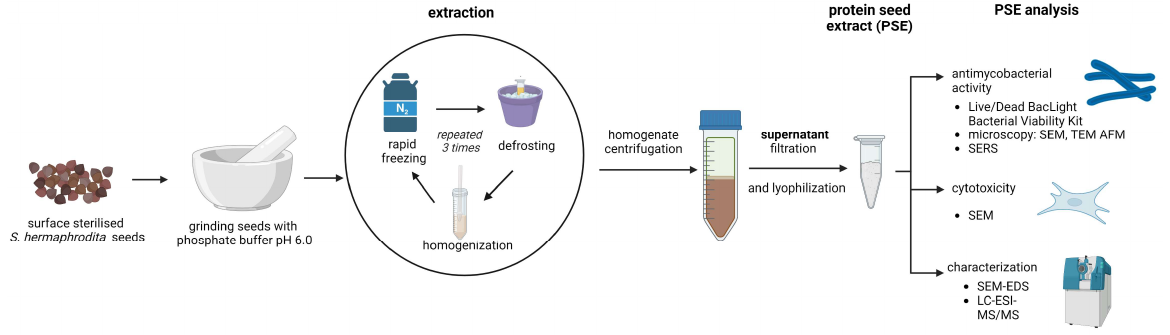
Figure 2. Scheme of seed extract preparation and analysis. Created with BioRender.com.